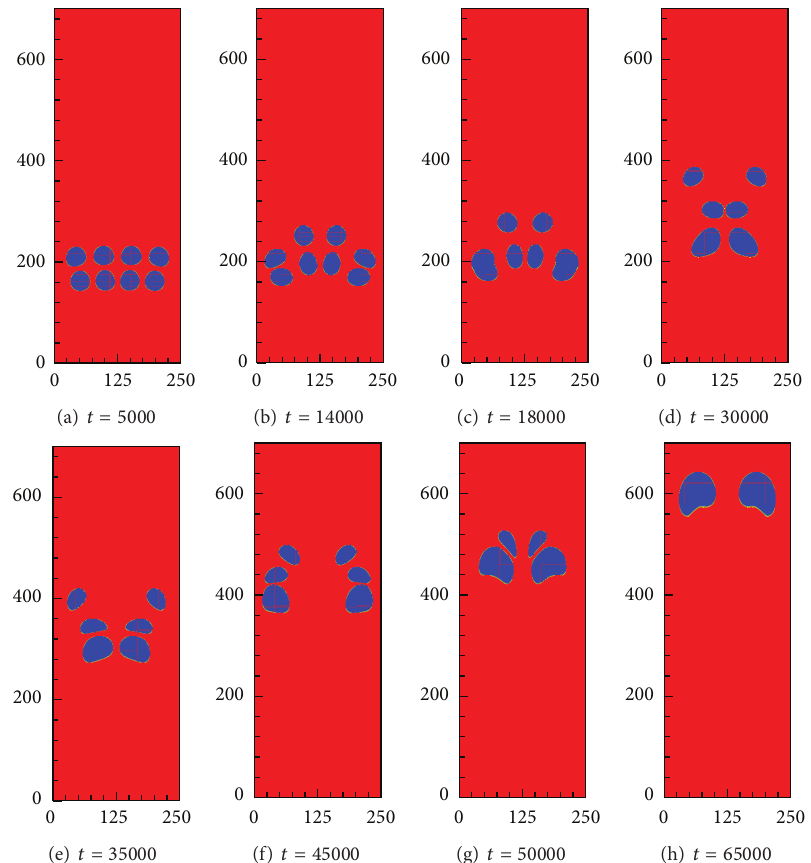
Figure 13: The contours of order parameter of eight bubbles for Eo = 5